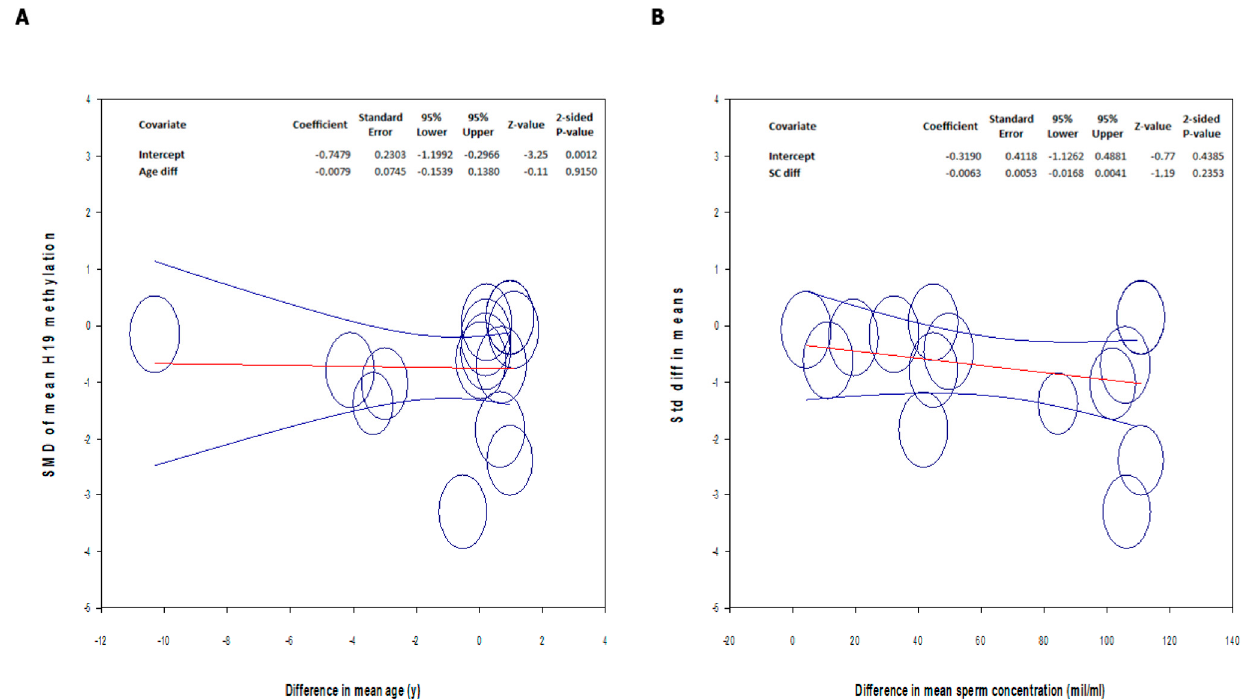
Figure 4. Meta-regression analysis between the standard difference of the mean H19 gene methylation and the difference in mean age ( A ) and sperm concentration ( B ). Circles represent the studies included in the analysis. The change in the mean and in the 95% CI are represented with the red and the blue lines, respectively.